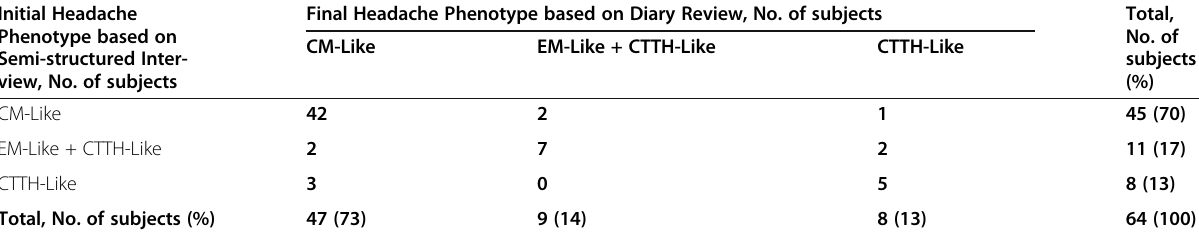
Table 4 Reclassification of Initial Headache Phenotype Diagnosis based on Diary Review Initial Headache Phenotype based on Semi-structured Inter- view, No. of